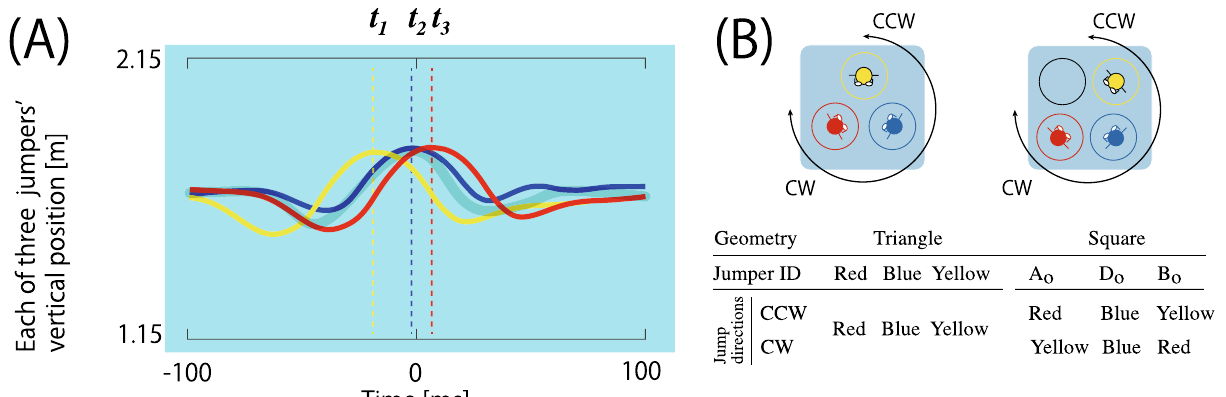
Figure 3. Vertical fluctuation of the jumper’s head and the definition of the (relative) positions of the three jumpers. ( A ) A typical example of the vertical head position of the three jumpers clipped from 100 ms before and after the peak of the averaged trajectory (shown by transparent gray trajectory). Each timing of the peak ( t 1,2,3 ) was defined as the timing of the jumping action. Each jumper’s jumping action to generate this trajectory is illustrated in the image at the top of Fig. 1A. The pattern of vertical movement around each jump was identical for all three jumpers and within 20 jumps. ( B ) Definition of the jumpers’ positions. In the triangle condition, the probability to be a lead jumper is calculated for each of the three jumpers’ positions identified by the initially assigned hoop color: red, blue or yellow. In the square condition, the probability to be a leader is calculated for each jumper in each position relative to the open hoop, including ahead , diagonal , or before of the open hoop identified as A o , D o , and B o , respectively. In the square condition, the jumper positioned in each of three positions differs according to the jumping direction, as shown in the table. Note that the red, blue, yellow, and black hoops were aligned in the same relative position for all seven triads, and the relative position of the three jumpers never changed considering they had to go back to the initially assigned hoop if they collided with each other (see, Fig. 1A–C, Supplementary Video